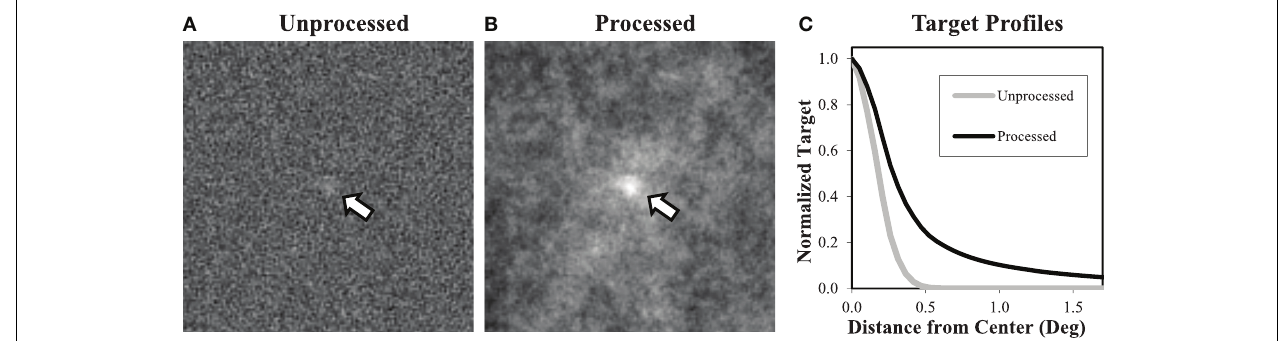
FIGURE 3 | Processing white noise images. Processing white noise images (A) with the appropriate filter gives them a β = 2 power-law background (B) . This transformation also changes the target profile, giving it much longer tails (C) . Target contrast (arrows) is enhanced here for display.